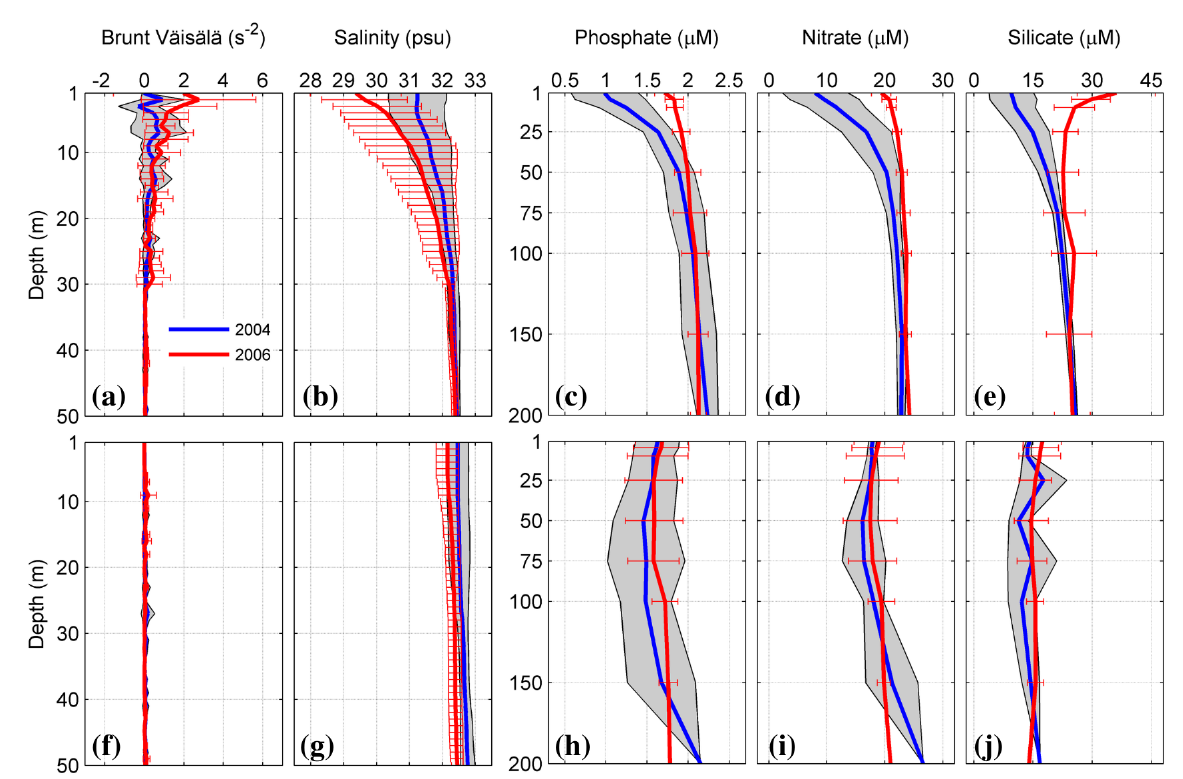
Figure 8. Mean vertical profiles of: ( a , f ) Brunt-Väisälä frequency, ( b , g ) Salinity, ( c , h ) phosphate, ( d , i ) nitrate, and ( e , j ) silicate. Top (bottom) panels correspond to profiles north (south) of Desertores Islands (see Figure 1) for the winter of 2004 (blue) and the winter of 2006 (red). For reference of the location of the oceanographic stations, see Figure